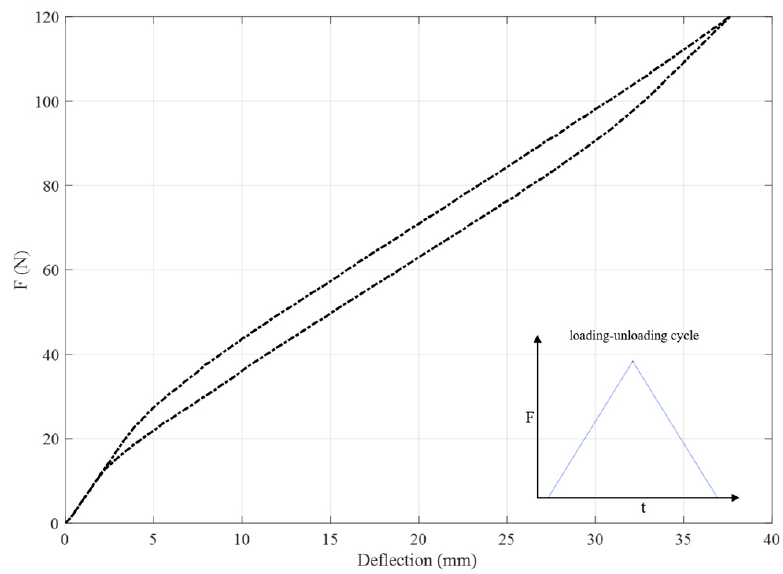
Figure 4. Tip force vs. vertical deflection of the hybrid plate ([(SMAHC)/0/0/0/0]) during a full loading–unloading